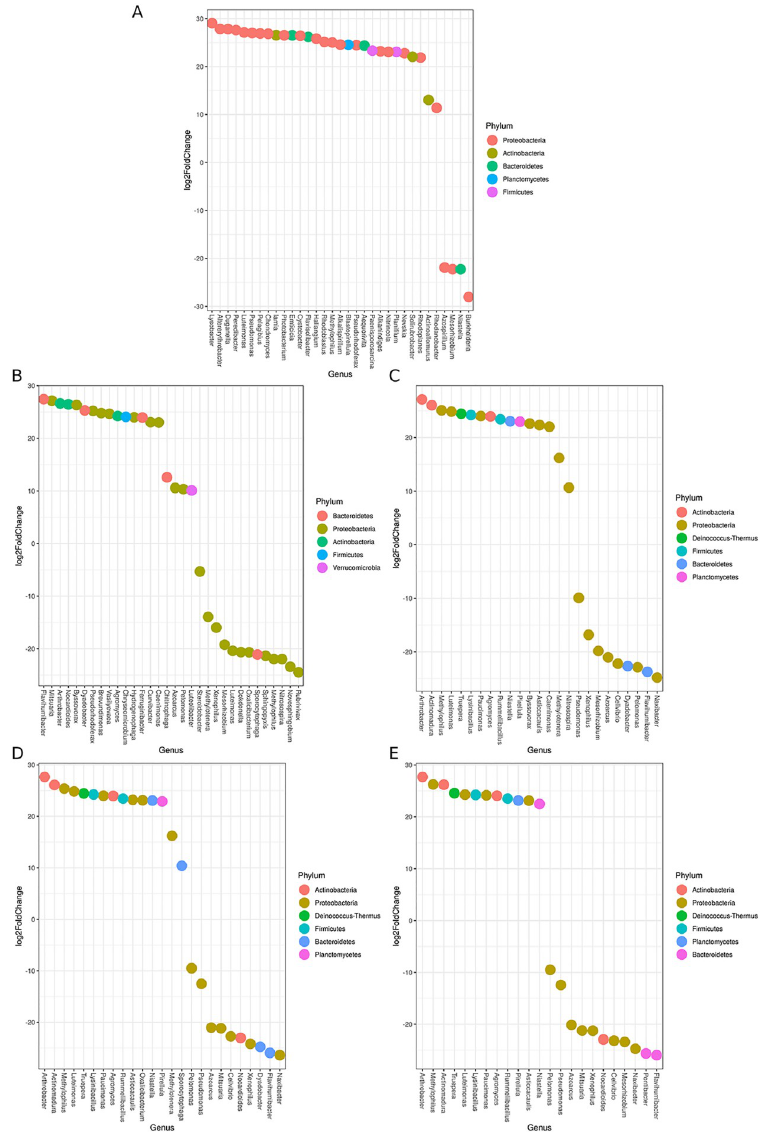
Fig 1. Log (2-fold) change of significantly differing genera between rhizosphere treatments. DESeq2 calculated differential abundance of significant (Benjamini-Hochberg adjusted p < 0.05) genera between (A) UVC and irrigated peat rhizospheres, (B) UVC and irrigated soil rhizospheres (C) fertigated and irrigated soil rhizospheres, (D) RVC and UVC soil rhizospheres, (E) SVC and UVC soil rhizospheres. Positive values represent an enrichment of the taxon in the first-listed treatment as compared to the second, i.e., in (A), positive values indicate that the taxa are more abundant in UVC peat rhizospheres than in irrigated. Colors correspond to the phylum while genera are listed on the